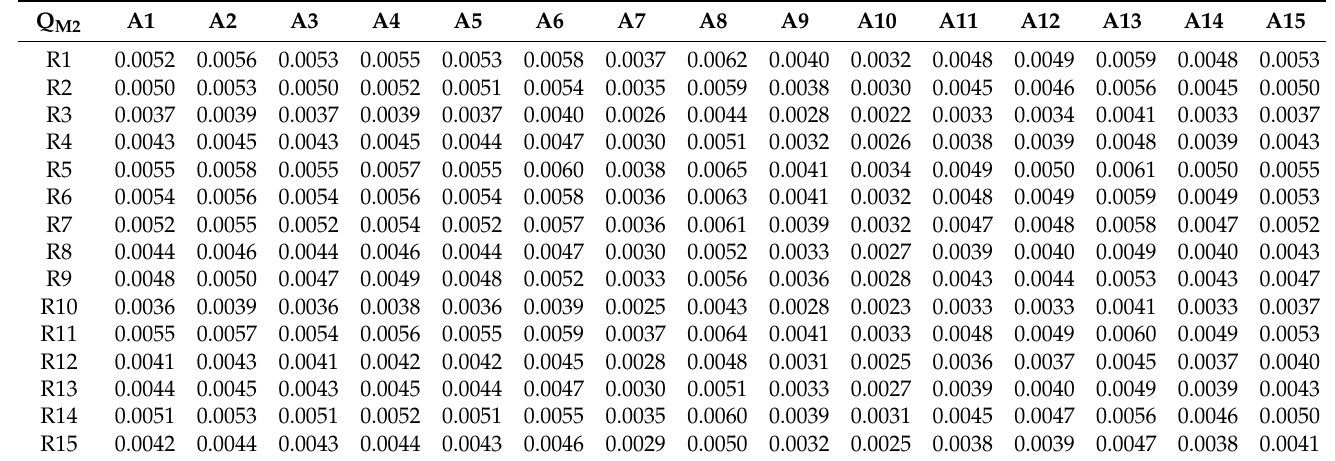
Table 9. Integrated evaluation matrix (Q M2 ) after normalization (Q M1 ).